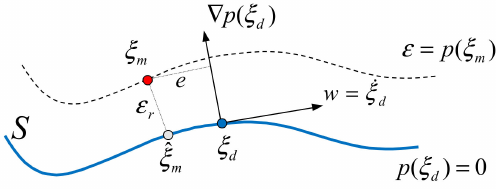
Figure 3. Actual contour error and equivalent contour